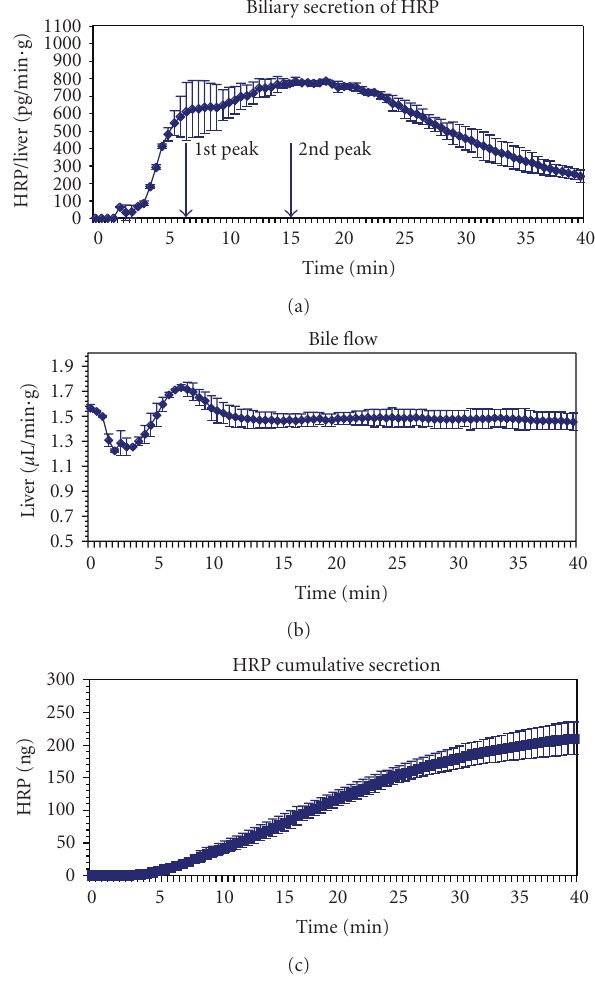
Figure 2: Kinetics of biliary secretion of HRP in the absence of mannan in the perfused rat liver. Isolated livers were perfused with HRP (0,8mg/mL) for 1 minute at 37 ◦ C (time 0) followed by a single pass perfusion with marker-free KHB at 37 ◦ C. The amount of HRP in single bile drops was determined and the secretion rate was calculated (a) based on the bile flow (b). Data shown are the mean ± SD five perfusions. (c) The total amount of HRP (cummulative HRP secretion) secreted into bile as a function of the perfusion time is shown.